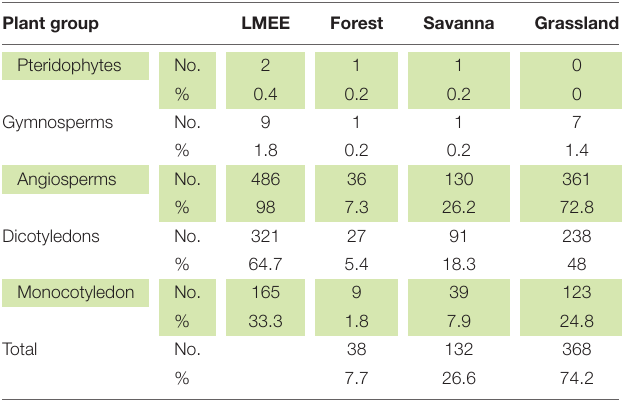
TABLE 1 | Distribution of endemics per major plant group among Biomes in the Limpopo–Mpumalanga–Eswatini Escarpment (LMEE). Plant group LMEE Forest Savanna